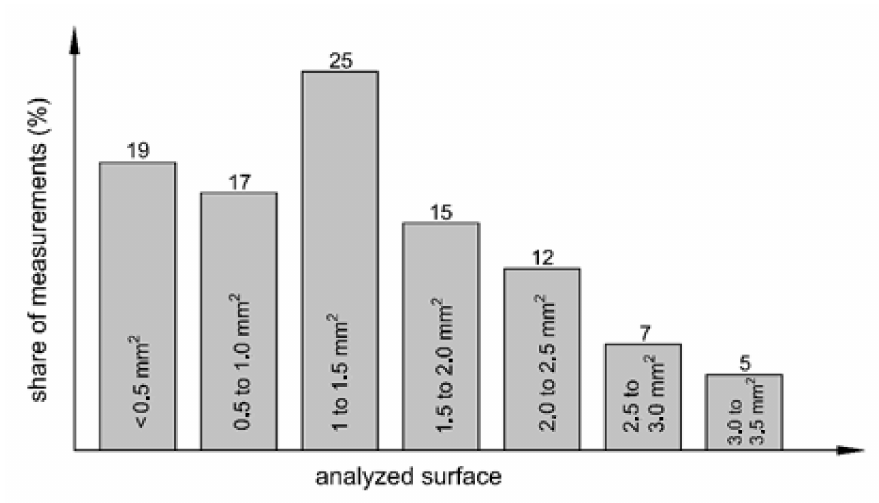
Figure 4. Distribution of the size of the measured surfaces with respect to all 84